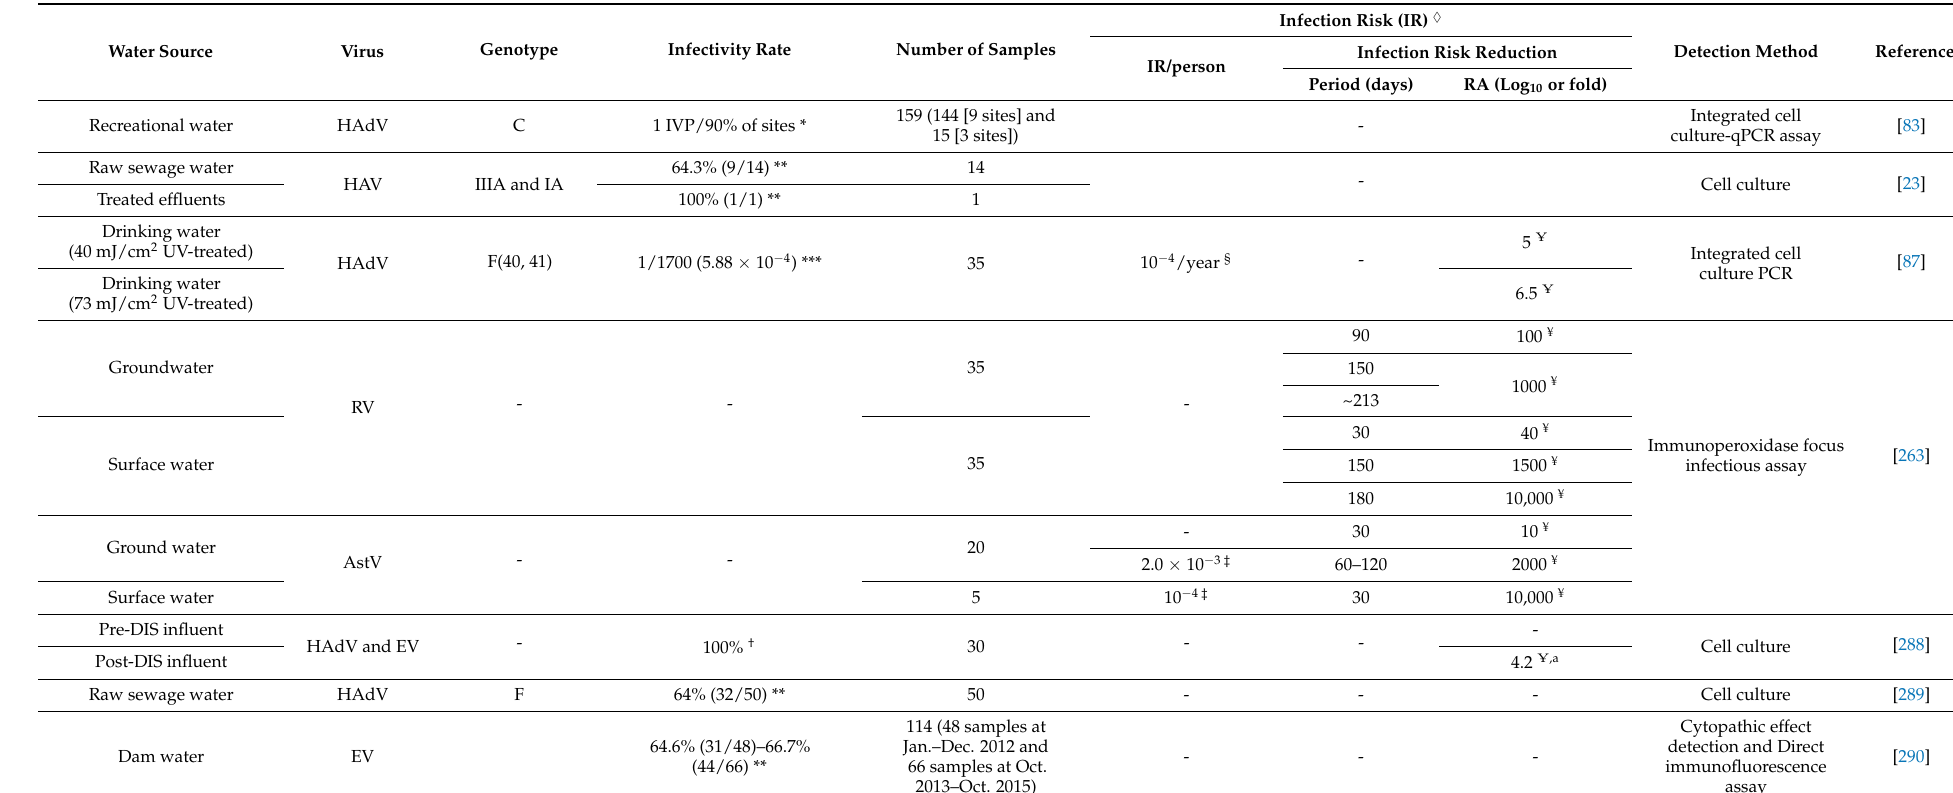
Table 6. Infectivity of enteric viruses in different water